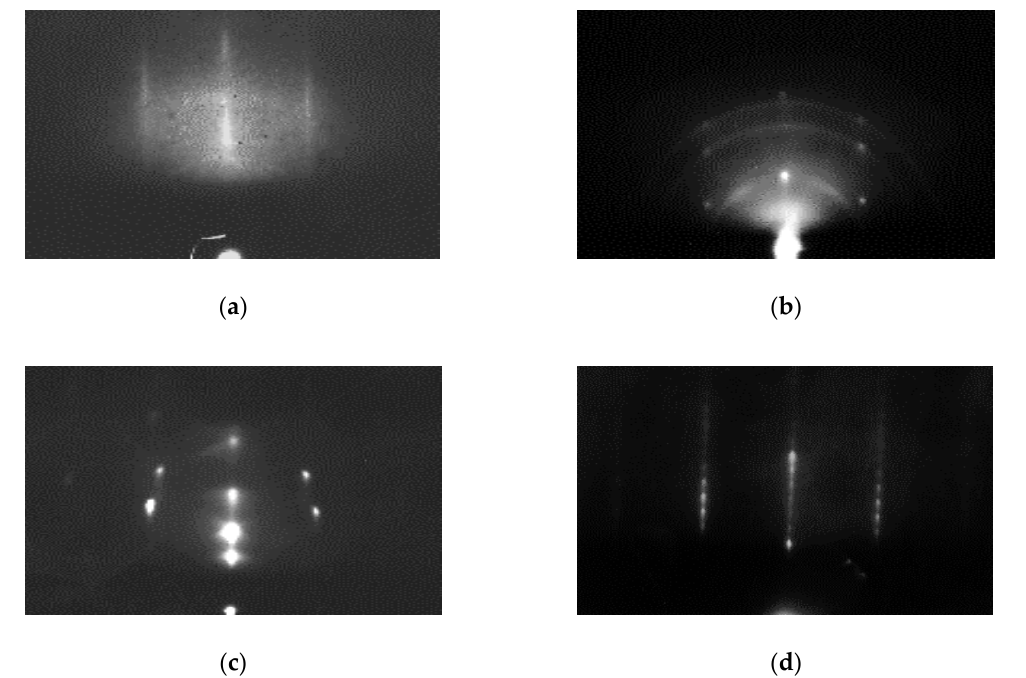
Figure 2. RHEED pattern of C-face (000 1 (cid:3364) ) -oriented 6H-SiC ion implanted with Al + at 80 keV and RTP annealed: ( a ) 5 × 10 14 cm − 2 , 800 K / 10 s (characteristic RHEED pattern for region A in Figure 2); ( b ) 5 × 10 16 cm − 2 , 2000 K / 5 s (characteristic RHEED pattern for region B in Figure 2); ( c ) 5 × 10 16 cm − 2 , 2100 K / 5 s (characteristic RHEED pattern for region C in Figure 2); ( d ) 5 × 10 15 cm − 2 , 2200 K / 5 s (characteristic RHEED pattern for region D in Figure 2). Azimuth [11 2(cid:3364) 0].